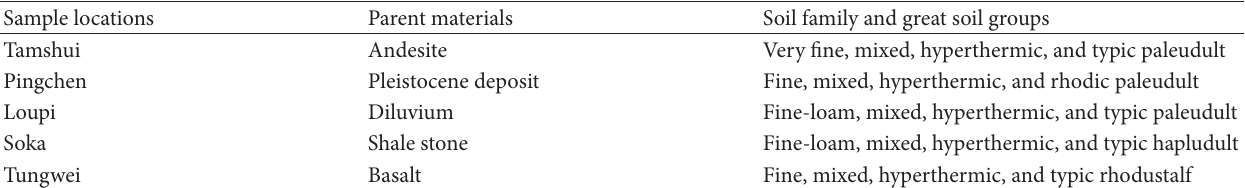
Table 1: Morphological characterization of the lateritic soils being